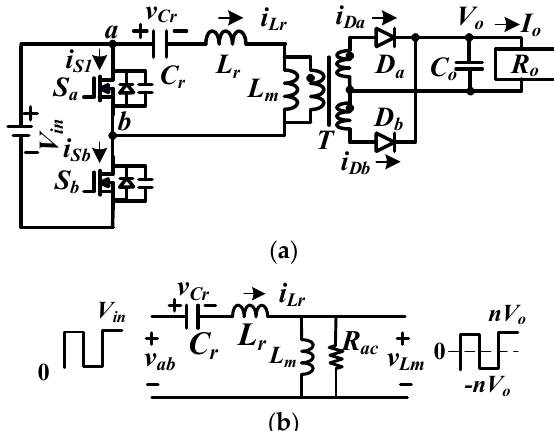
Figure 2. Conventional resonant converter ( a ) circuit structure and ( b ) AC equivalent circuit on primary side.